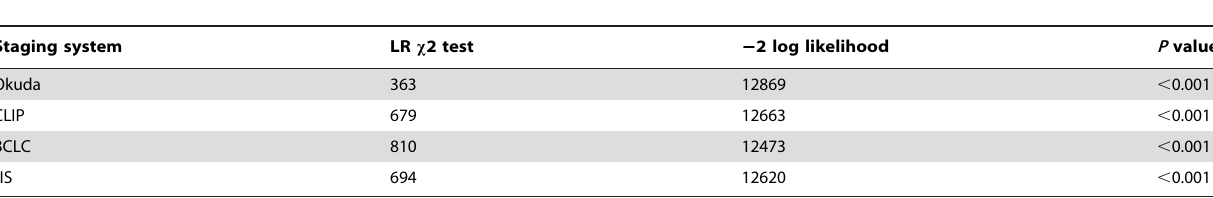
Table 6. Likelihood ratio on entry of individual staging systems as factors in Cox regression model for the whole cohort.